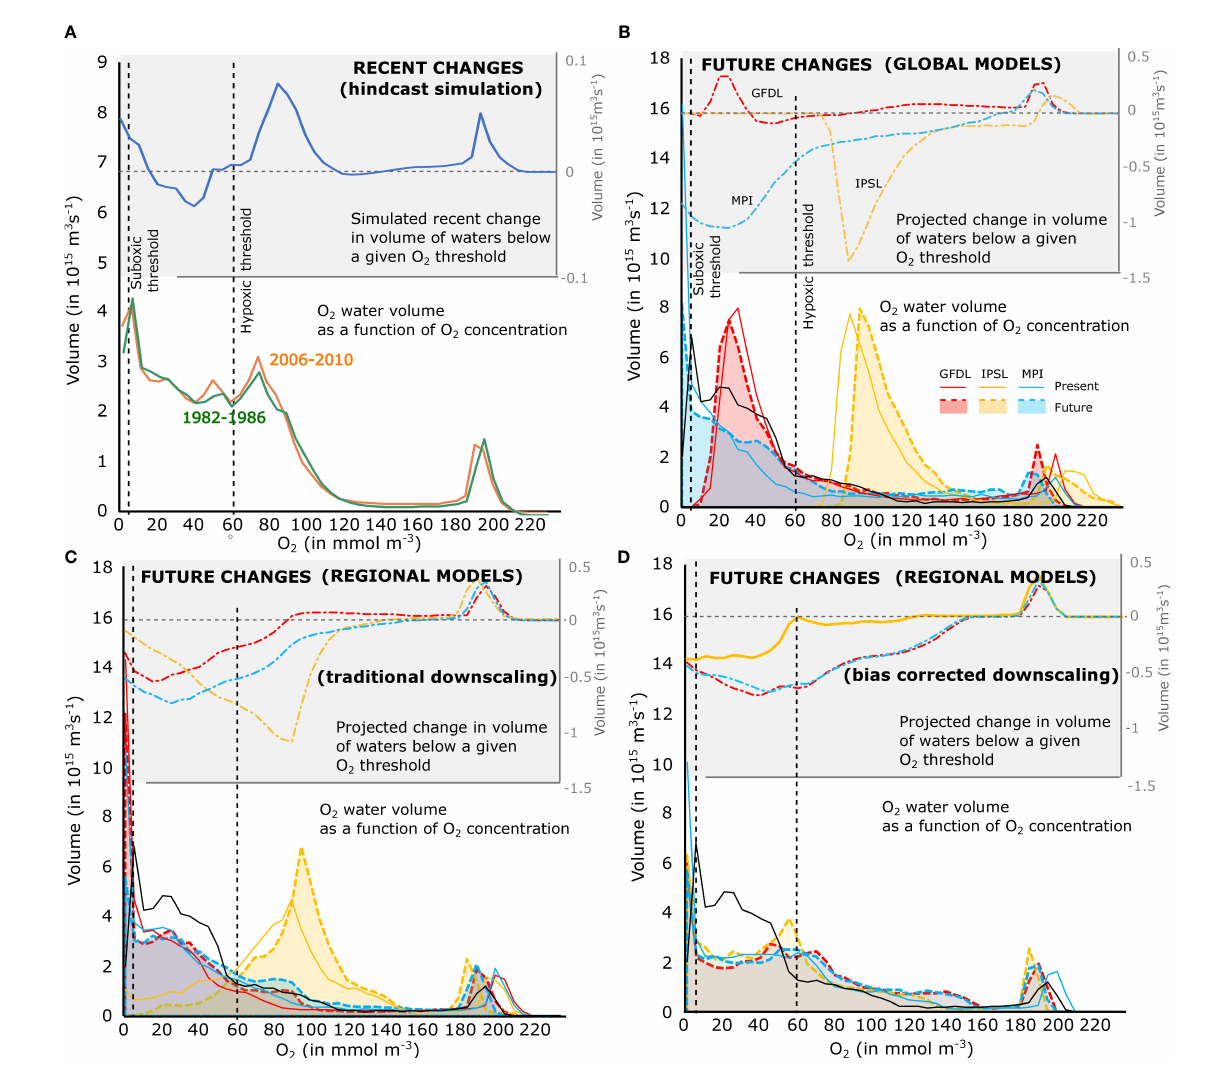
FIGURE 5 Recent and future changes in O 2 frequency distribution in the Arabian Sea. (A) O 2 frequency distribution in the Arabian Sea as simulated in the early 1980s (green) and the late 2000s (orange) as well as the cumulative frequency of simulated O 2 change over the 1982-2010 period (blue, right axis) from (Lachkar et al., 2021). Note the expansion of poorly oxygenated waters (O 2 < 100 mmol m -3 ) as well as waters with extreme O 2 depletion (O 2 < 10 mmol m -3 ). (B – D) O 2 frequency distribution in the Arabian Sea in the present-day (solid line) and in the future (dashed fi lled area) as well as cumulative frequency of future O 2 change (dash-dotted line, right axis) as simulated by (B) three global models (MPI, GFDL and IPSL) and a regional model (ROMS) forced with the three global models using traditional (C) and bias-corrected (D) downscaling approaches. Traditional downscaling consists in forcing the regional model with boundary conditions simulated by the global model, whereas bias-corrected downscaling (also known as pseudo global warming) consists in constructing regional model lateral boundary conditions by adding global model projected changes onto observational data. (B – D) Note the reduction in model discrepancies in future O 2 projections in the downscaled experiments, particularly when using the bias-correction approach, relative to the global simulations. Adapted from Vallivattathillam et al. (in